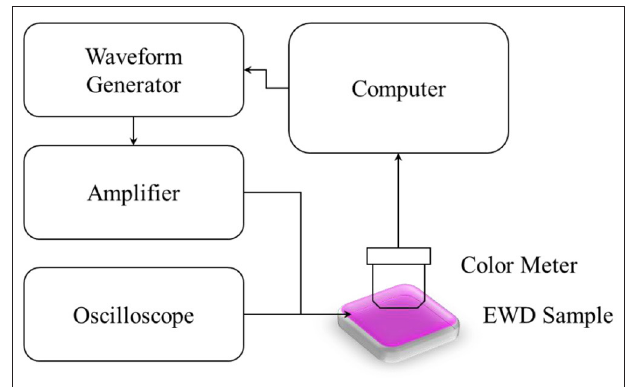
FIGURE 3 | System diagram of the experimental platform. The experimental platform was mainly composed of an arbitrary waveform generator, an amplifier, an oscilloscope, and a colorimeter. The magenta EWD panel was used in experiments.